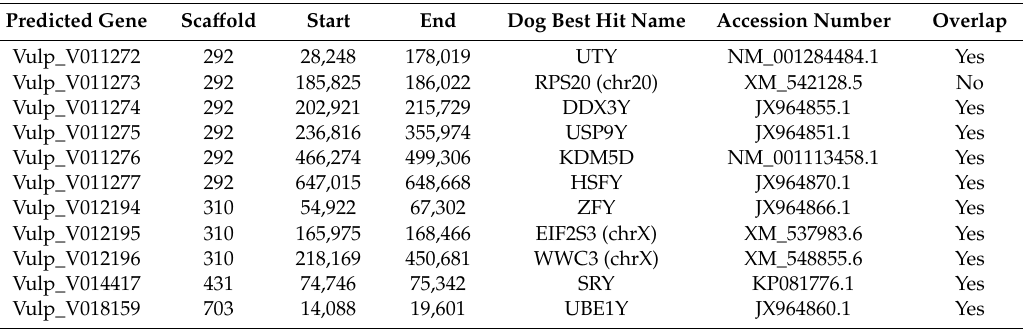
Table 4. Dog orthologs of red fox predicted genes. The best-hit canine protein sequence was selected using protein BLAST (blastp) against NCBI protein database. When the best-hit gene is not located on the dog Y-chromosome, its chromosomal position is also indicated. The overlap column describes whether the position of the predicted gene in the red fox genome overlaps the position assigned using the dog version of the gene as a query against the fox